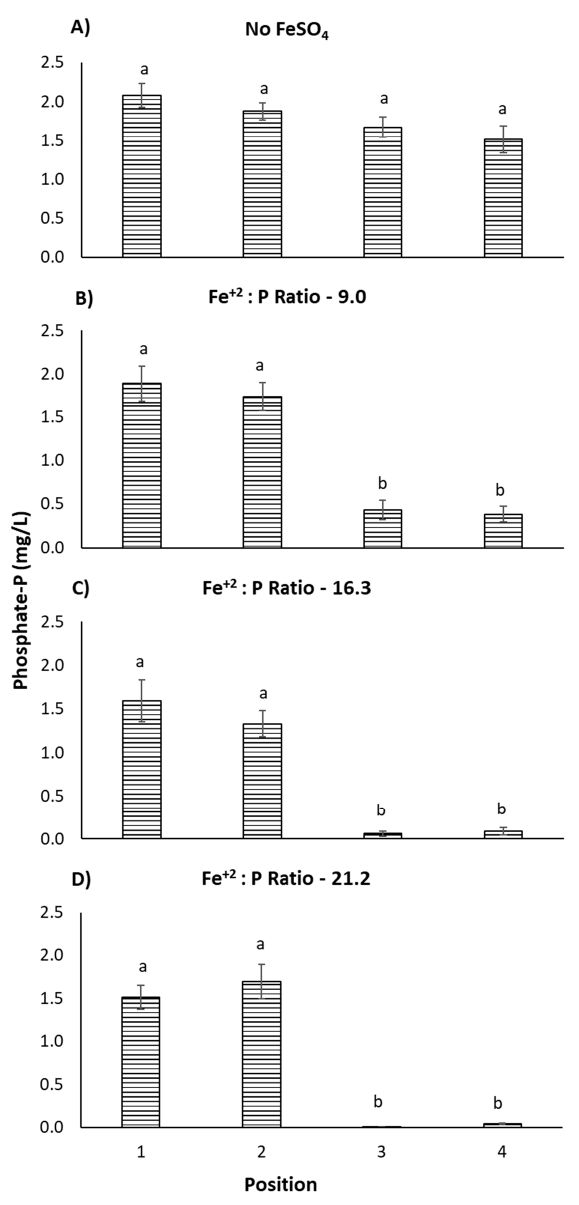
Figure 3. Phosphate concentrations (mg / L) relative to FeSO 4 dosing rates in tanks at positions 1, 2, 3, and 4 in the bioremediation treatment-train. Different letters indicate differences amongst positions relative to Fe 2 + :P dosing ratios as indicated by ANOVA with LSD Means calculations ( P = 0.05).